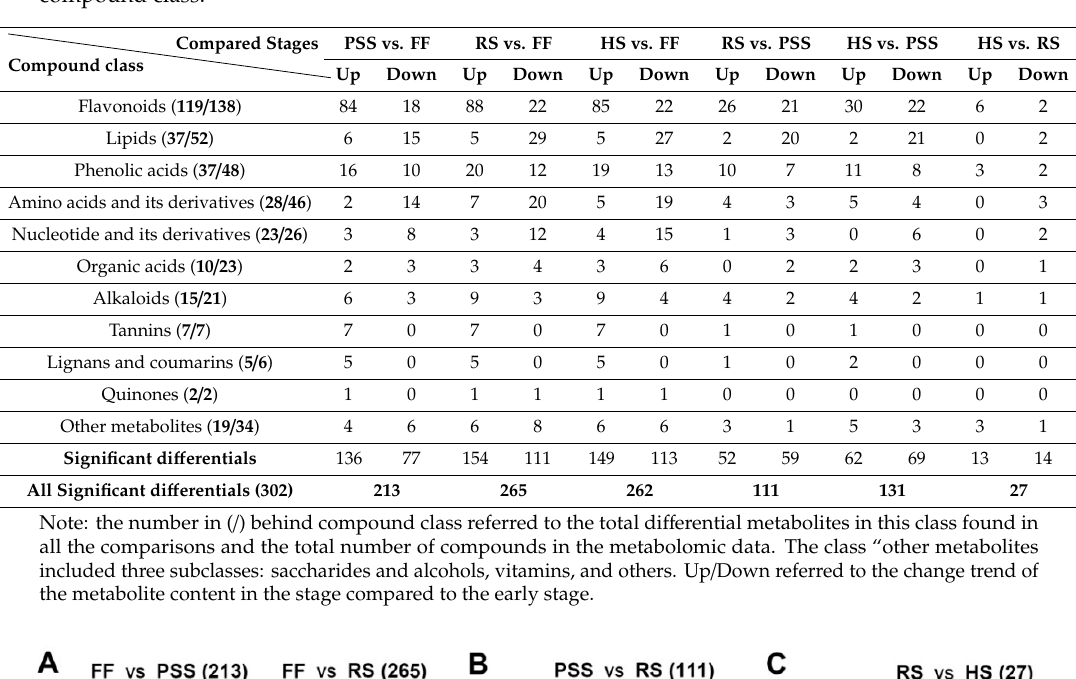
Number of di ff erential metabolites found in di ff erent pairwise comparisons and compound class.